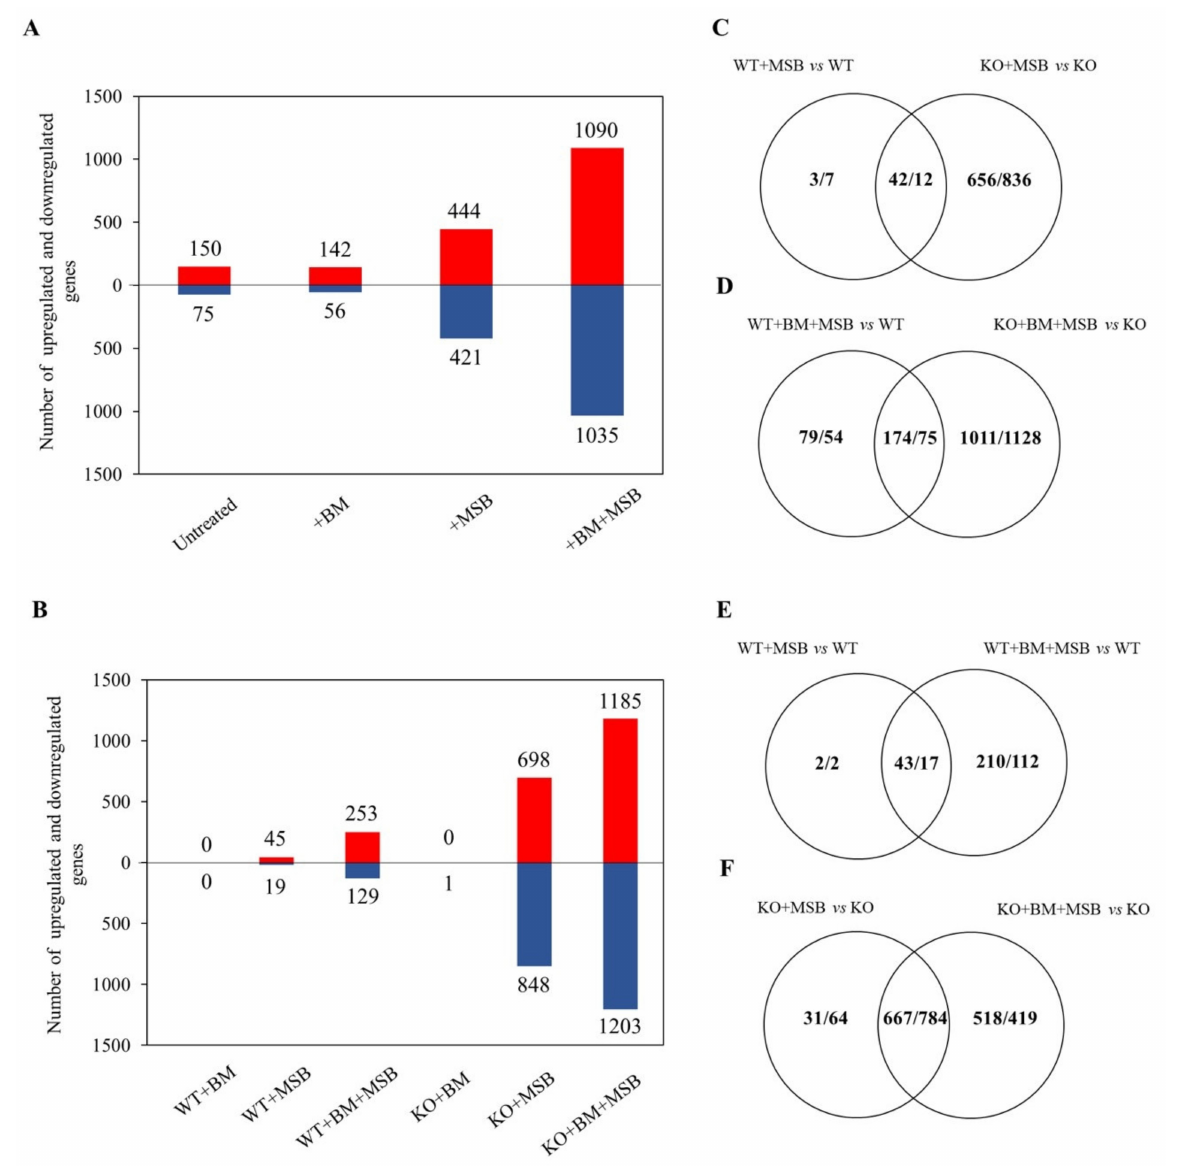
Figure 2. Effects of C. albicans protein phosphatase Z1 ( CaPPZ1 ) deletion and stress conditions on the transcriptome of C. albicans . ( A ) Number of genes up- or down-regulated due to CaPPZ1 gene deletion alone (untreated) or in the presence of betamethasone (BM), menadione sodium bisulfite (MSB) or BM + MSB as compared to WT under the same experimental conditions. Significantly up- and down-regulated genes with a corrected p value of <0.05 were taken into consideration during the evaluation process. ( B ) Number of genes that were up- or down-regulated by BM, MSB or BM + MSB treatments in the QMY23 (WT) or cappz1 mutant (KO) strain. In ( A , B ) up- and down-regulated genes are represented by red and blue bars, respectively. ( C – F ) Venn diagrams show the number of up-regulated over down-regulated genes under MSB or BM + MSB treatment conditions in four different comparisons. The effects of CaPPZ1 gene deletion, BM pre-treatment and/or oxidative stress (MSB) on the growth rates are presented in Figure